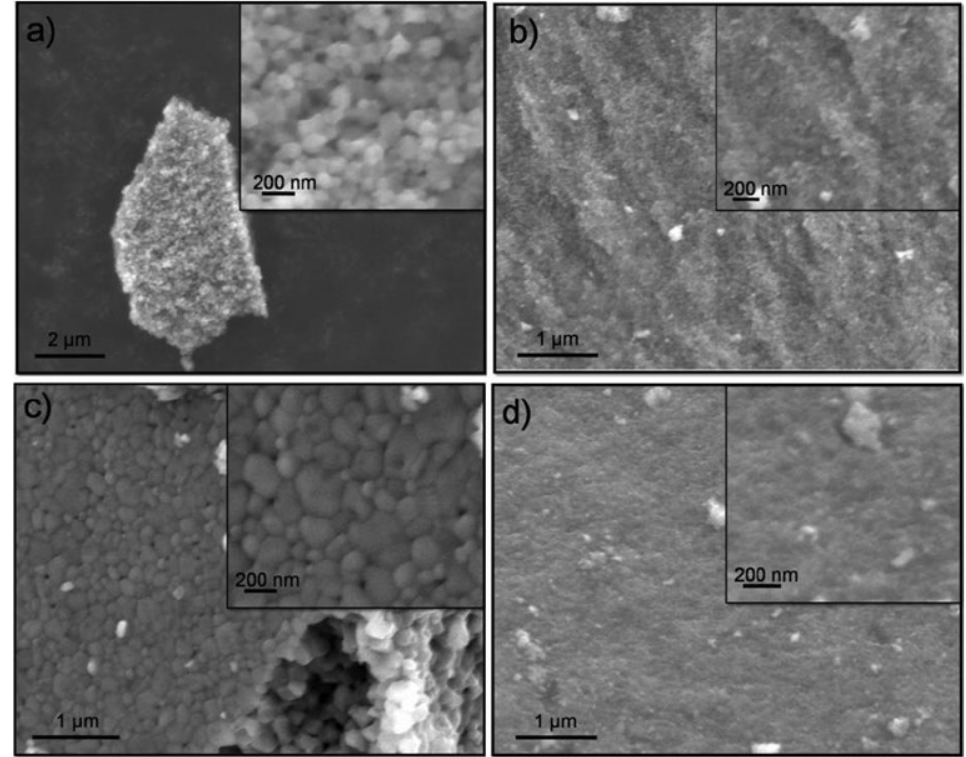
Figure 8. SEM micrographs of powders: a) 0% PO 43– , 800 °C b) 15% PO 43– , 800 °C c) 5% PO 43– , 1000 °C and d) 5% PO 43– , 500